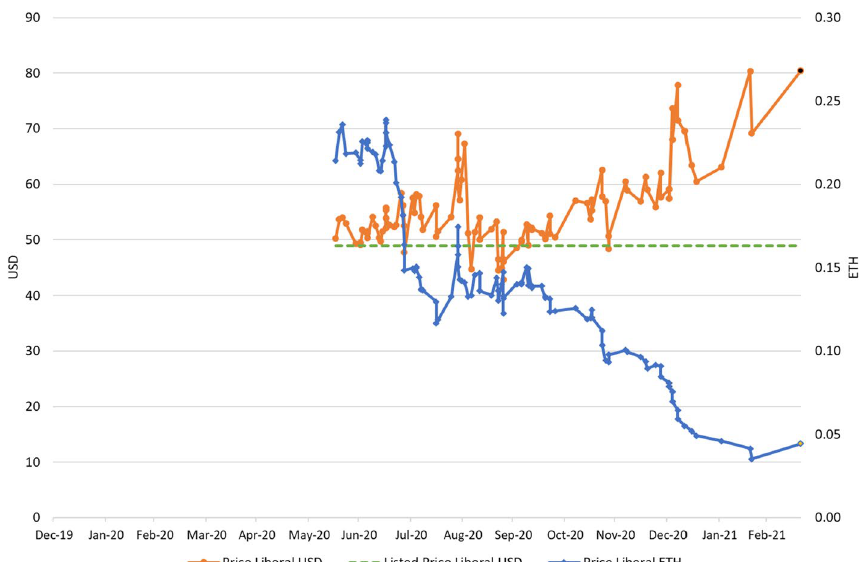
Fig. 20 Price (in USD and ETH) of 15,634 Liberal Street Detroit MI. Each dot represents one transaction. Last colored dot is ask price on